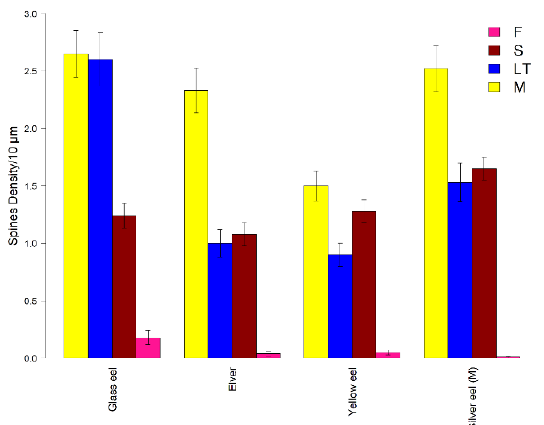
Figure 7. Mean density of dendritic spines. Mean spine density per 10 µm in the European eel per life stage and per spine class (M: mushroom in yellow, LT: long thin in blue, S: stubby in red, F: filopodia in pink). Error bars represent standard error of the mean.